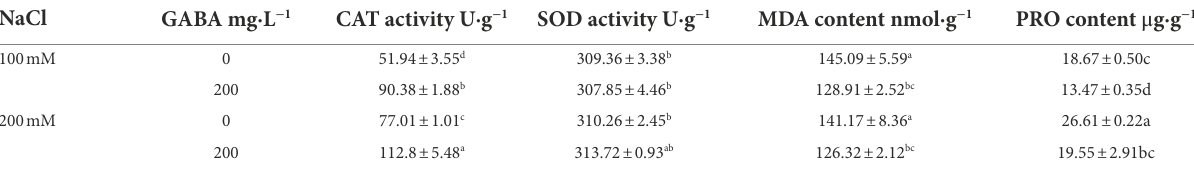
Different lower-case letters in each column shape indicate a significant difference at p < 0.05 by statistical